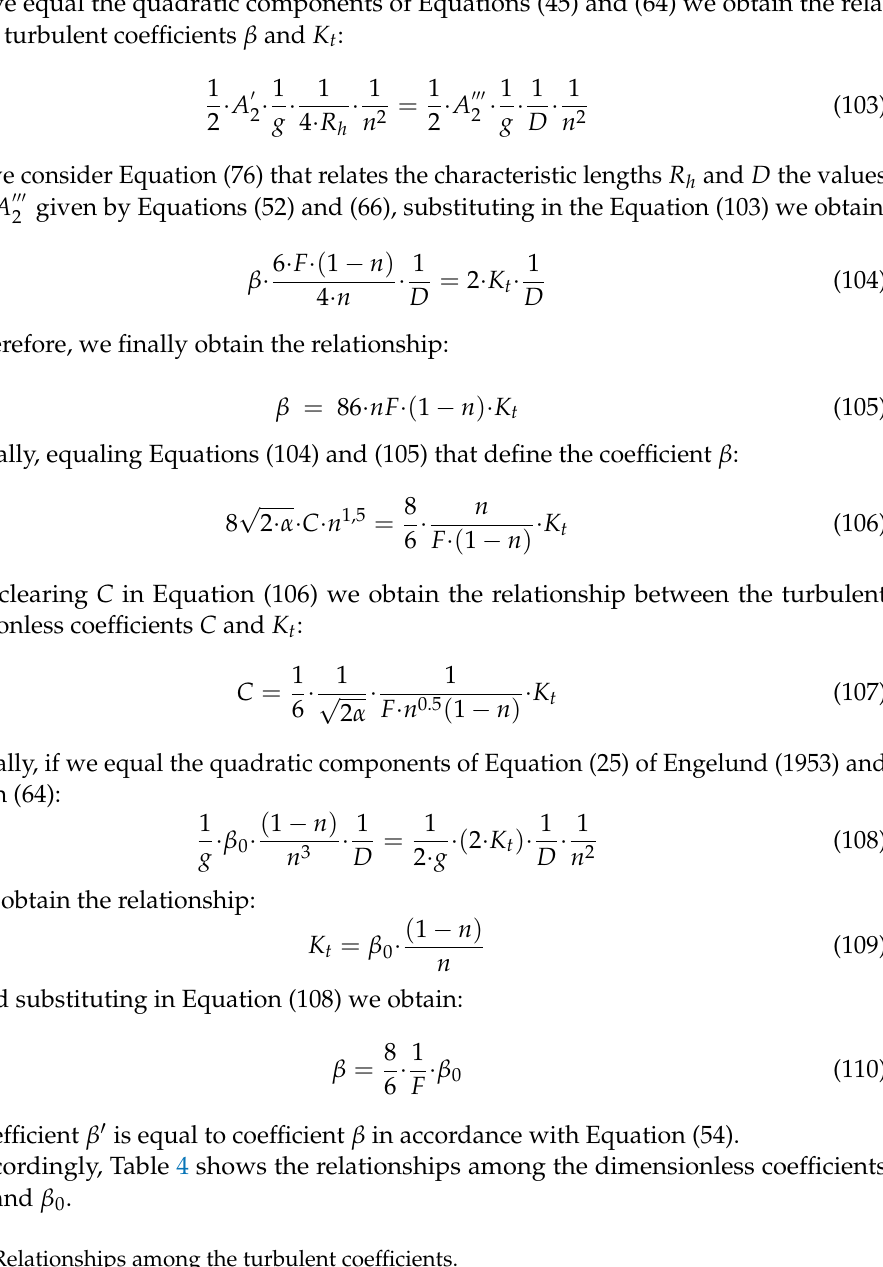
Table 4. Relationships among the turbulent